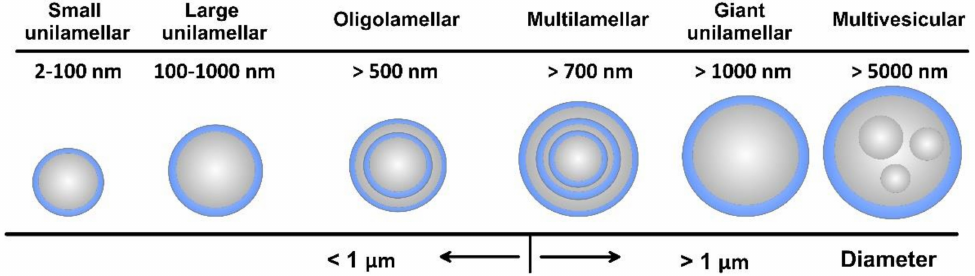
Figure 4. Overall view of liposome types together with their indicative